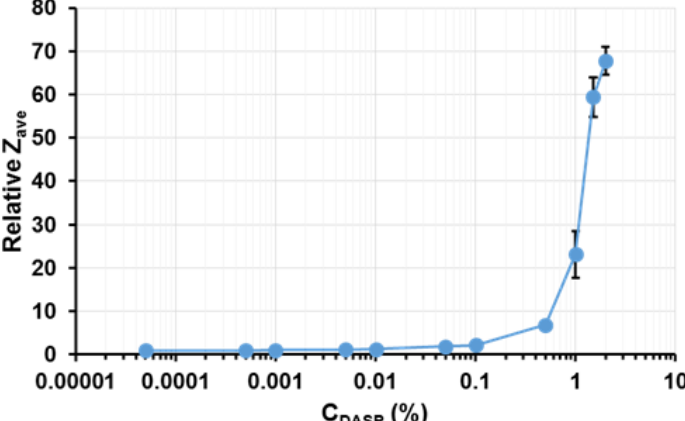
Figure 2. Relationship between the relative mean hydrodynamic diameter (relative Z ave ) and the DASP fraction concentration (C DASP ); the bars indicate standard deviation.